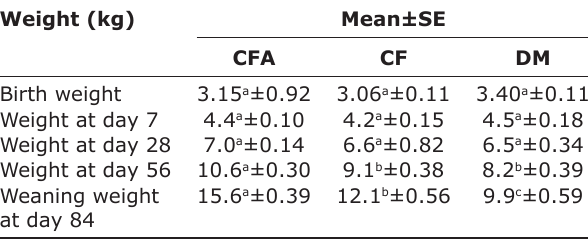
Table-4: Average weights of kids from CFA, CF and DM groups at different periods of the experiment (n=16).